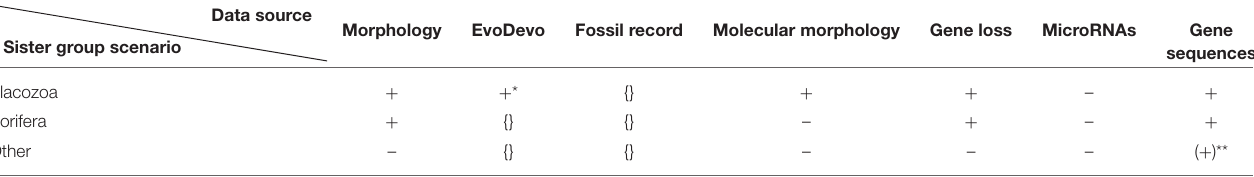
TABLE 1 | Data sources for resolving the root of the metazoan